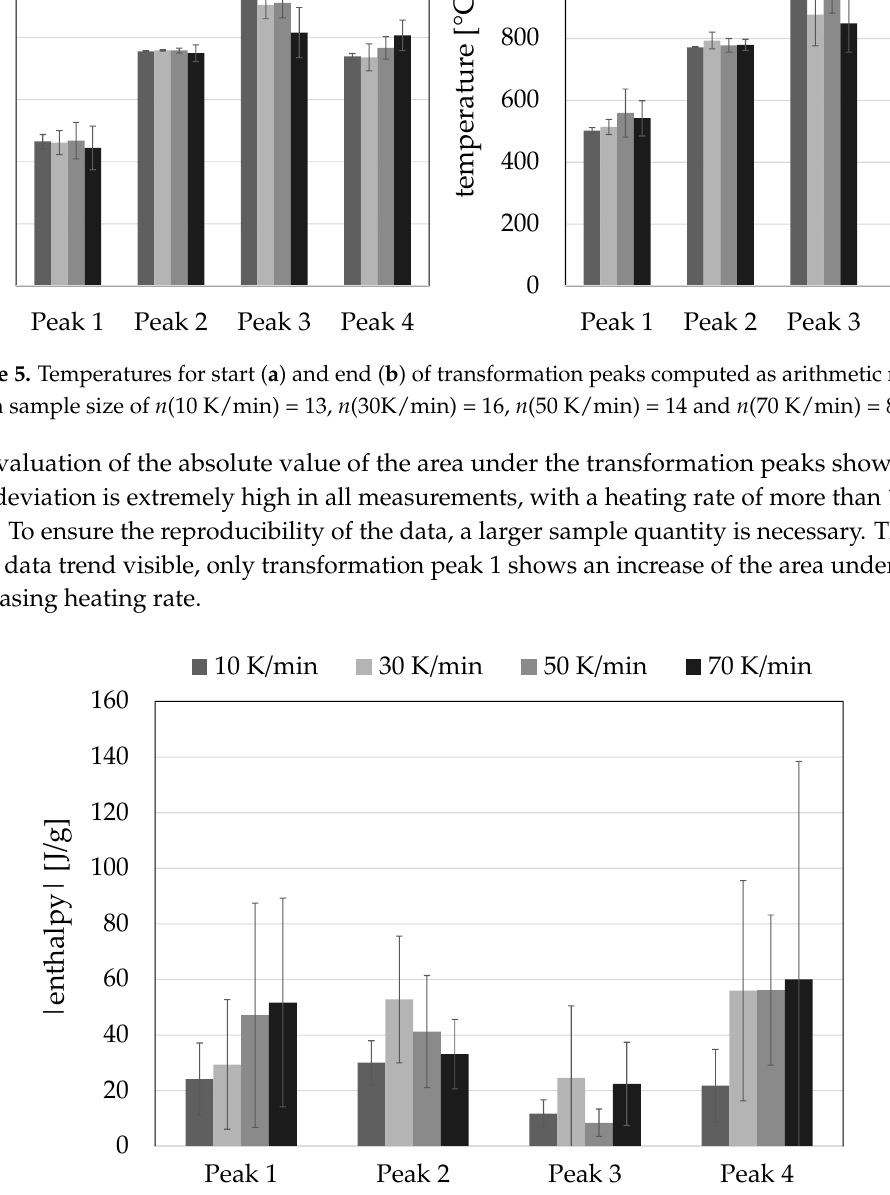
Figure 6. Absolute value of the area under transformation peaks with varying heating rates. As in Figure 5, these are arithmetic means computed with a sample size n > 7.